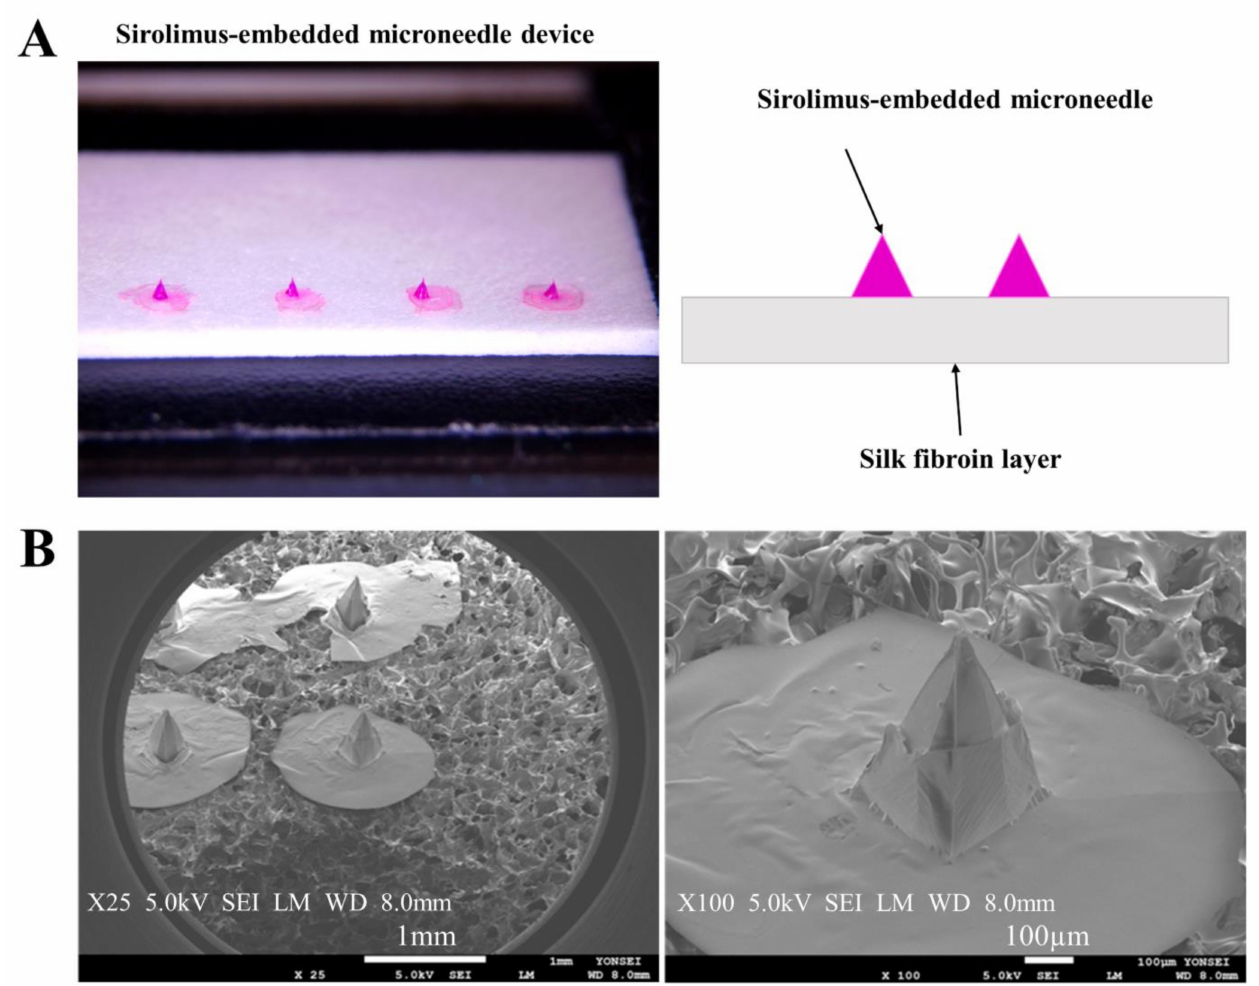
Figure 9. Design of sirolimus-embedded silk microneedle (MN) wrap. ( A ) Schematic design of the sirolimus-embedded silk MN wrap and ( B ) scanning electron microscope images of silk MN arrays on the porous silk wrap. Scale bars indicate 1 mm and 100 µ